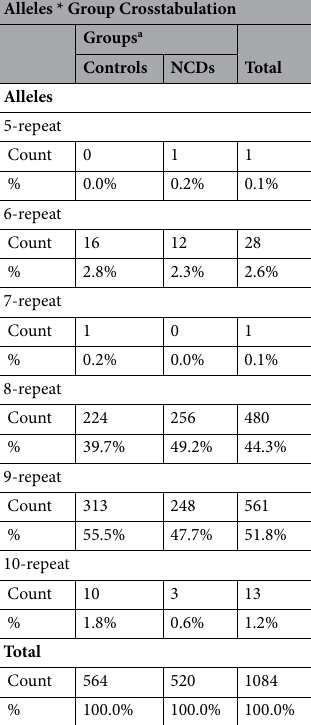
Table 1. Allele distribution of the human SBF1 (GCC) repeat in the NCD and control groups. a Fisher’s exact p = 0.006. Counts and % represent within each group.